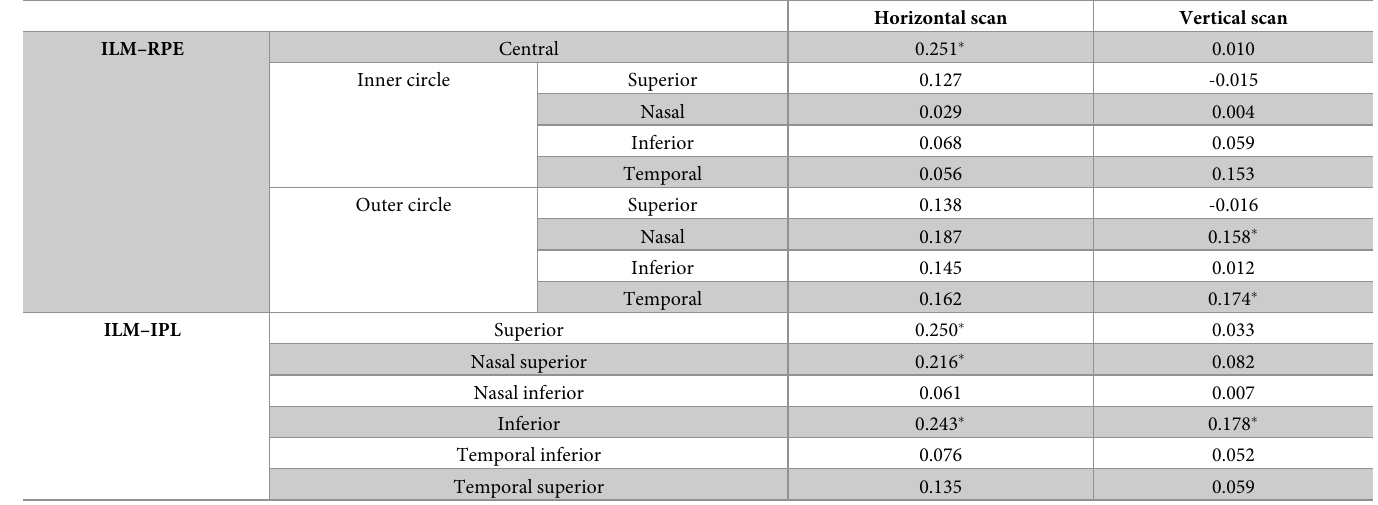
Table 4. Correlation values between the repeatability and age for the macular scans.